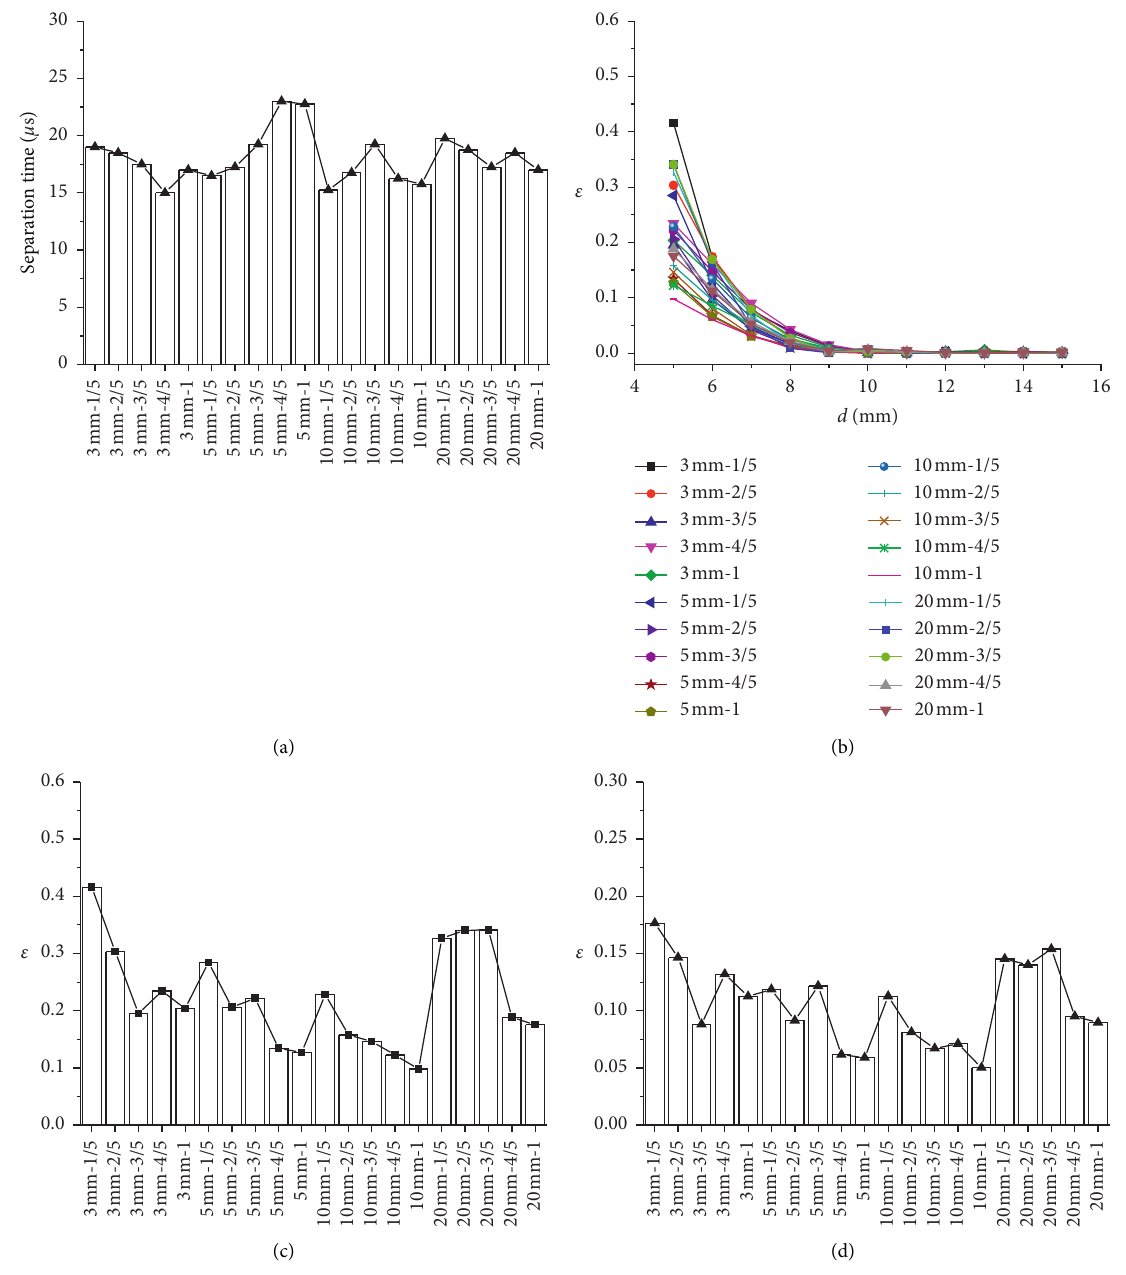
Figure 11: Effect of weakening grooves on cutting results: (a) separation time; (b) ε at different distance; (c) ε at d � 5 mm; (d) average of ε from d � 5mm to d � 8